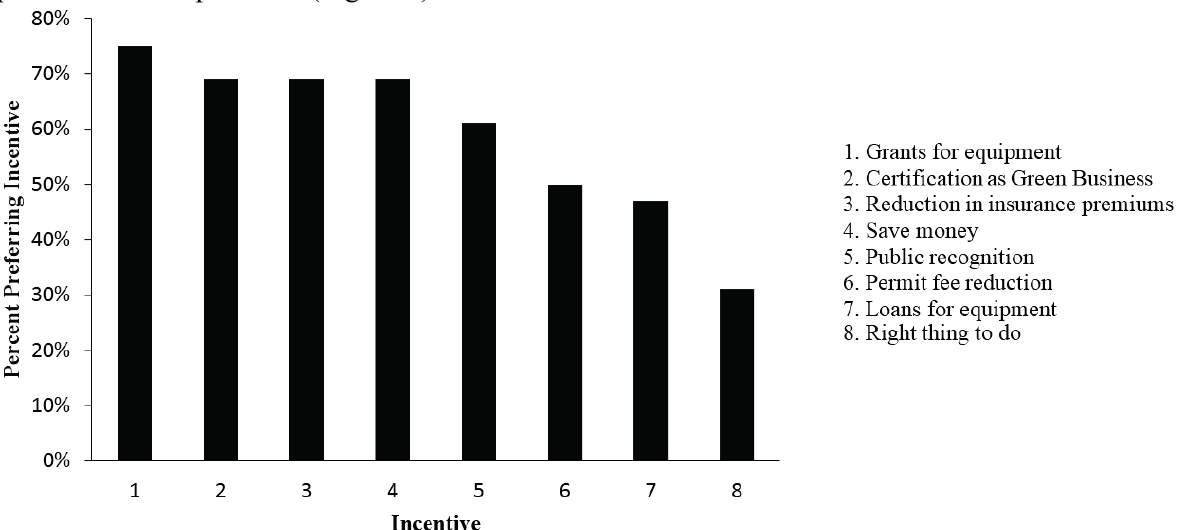
Figure 1. Preferred incentives selected by small and home-based businesses that would help foster P2 practices